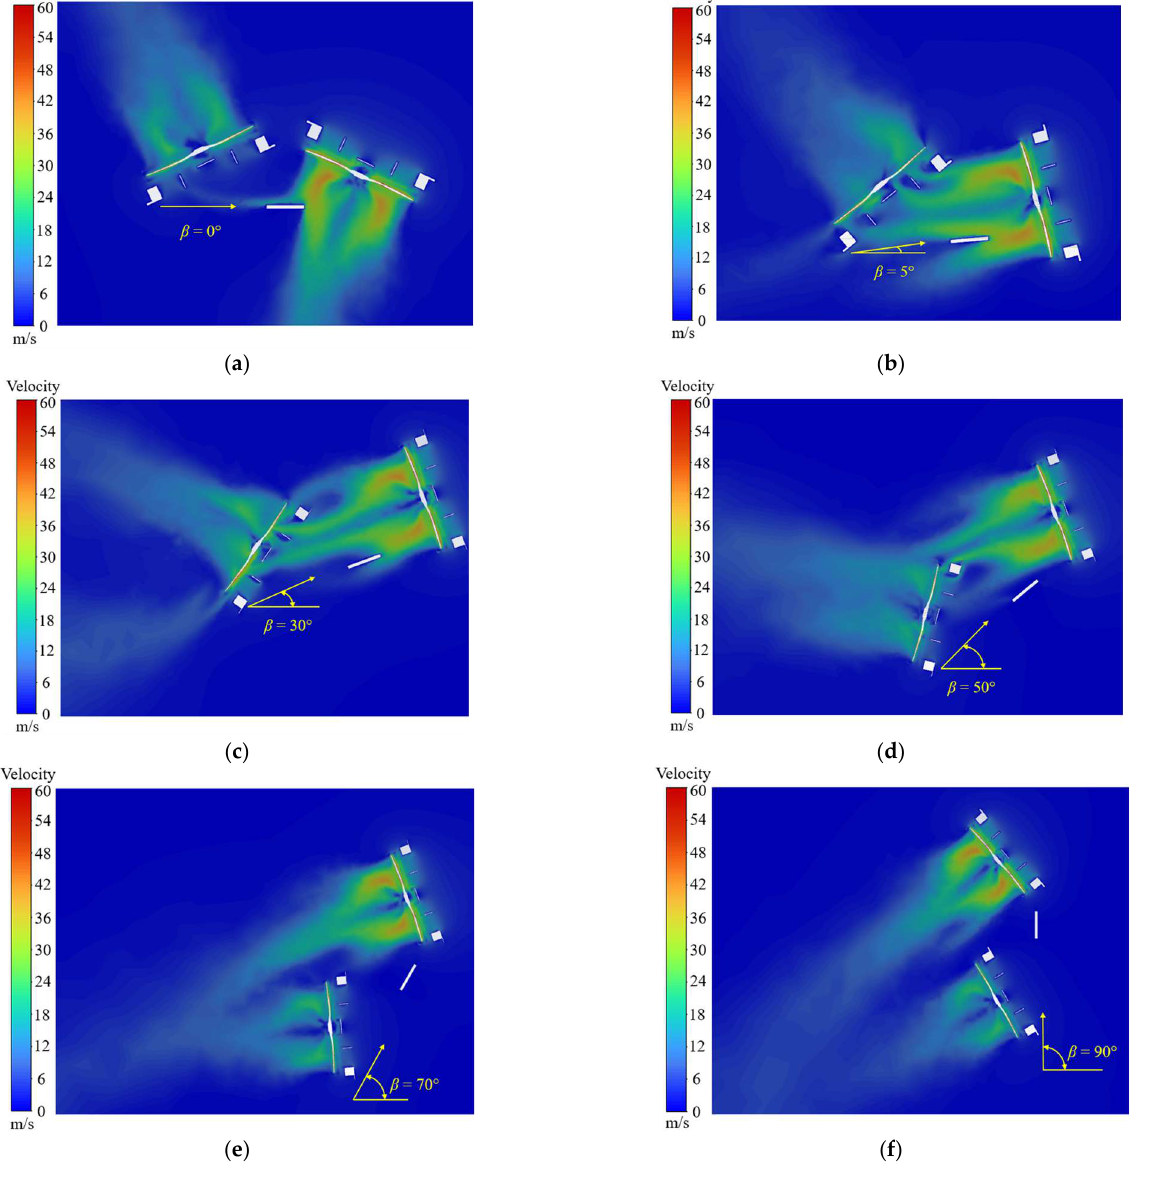
Figure 11. Velocity contours of DP-Climb critical transition nodes: ( a ) β = 0°; ( b ) β = 5°; ( c ) β = 30°; ( d ) β = 50°; ( e ) β = 70°; ( f ) β = 90°. The relationship between the pitch angle of the robot body and the front and rear rotor platforms is shown in Table 3.